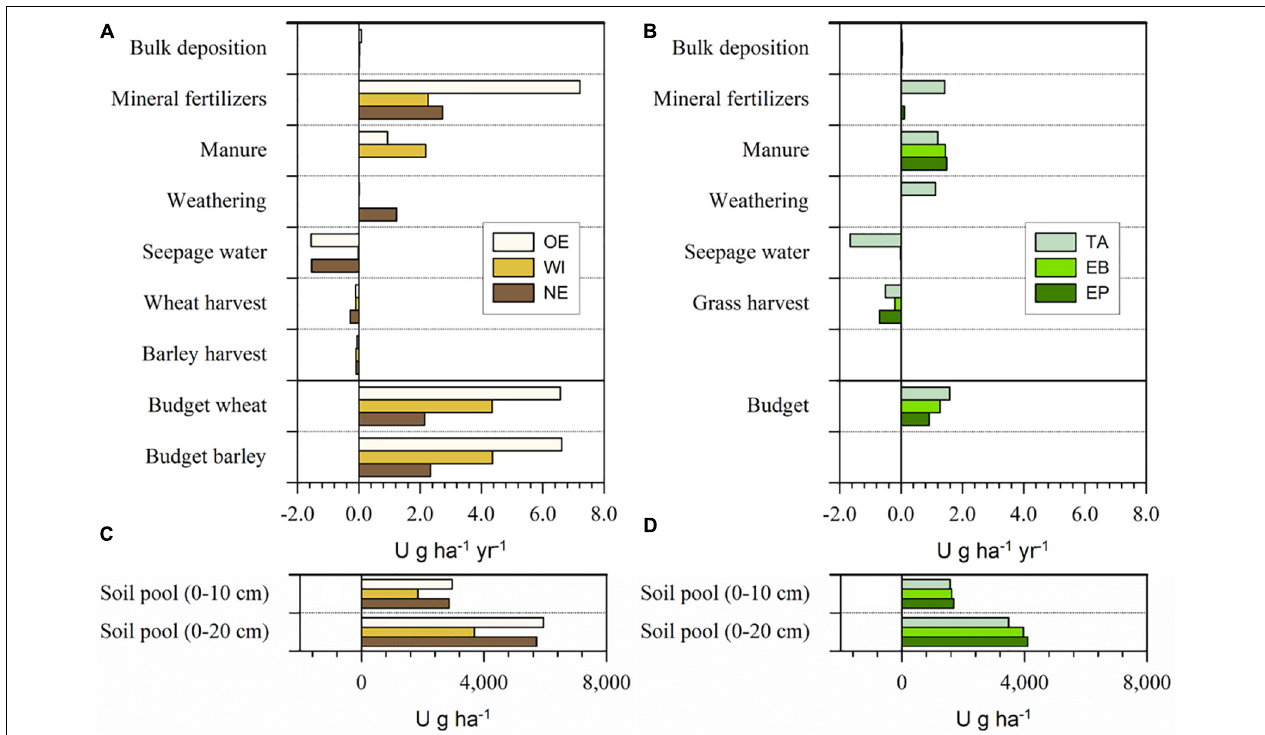
FIGURE 3 | Uranium budgets of (A) the three arable soils at OE, WI, and NE and (B) the three grassland sites TA, EB, and EP for one hydrological year (May 2014–May 2015) and the U soil pools at the (C) arable and (D) grassland sites. Mass budgets were calculated individually for wheat and barley cropping considering the respective U removal by the yield (straw and grain) for the arable sites. Please mind the different labeling of the axes in (A,B) compared to (C,D)